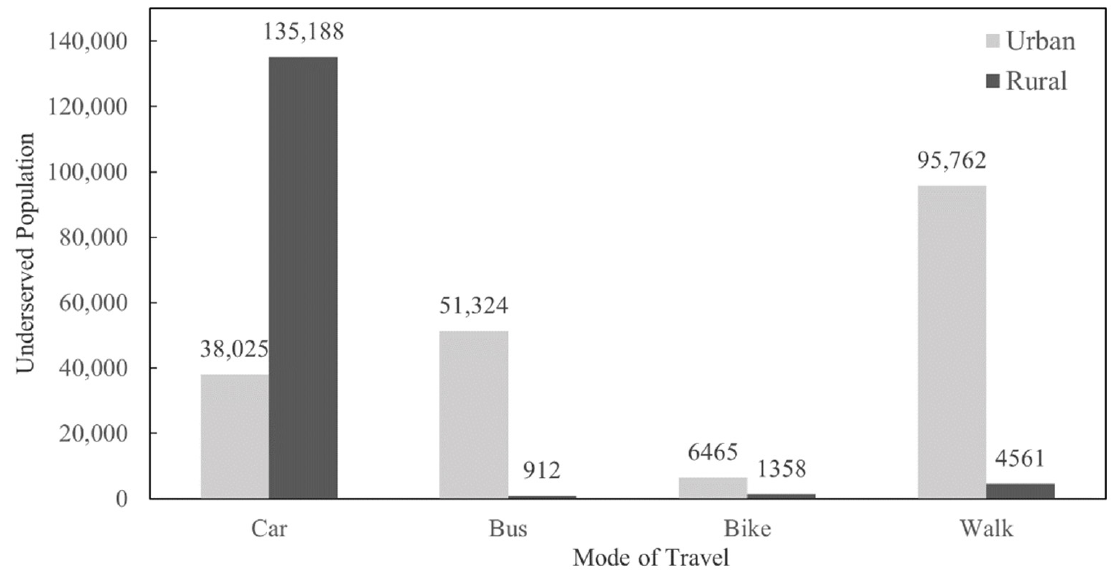
Figure 5. Comparison of underserved populations (estimated from the eRFEI) by residence and travel